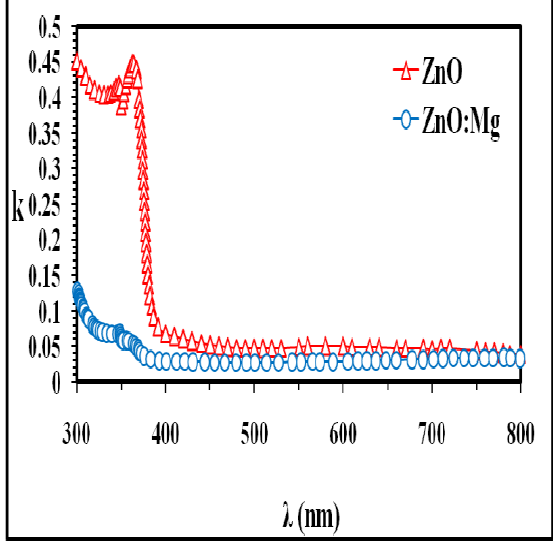
Fig.5: Variation of K as a function of wavelength of ZnO pure and doped.